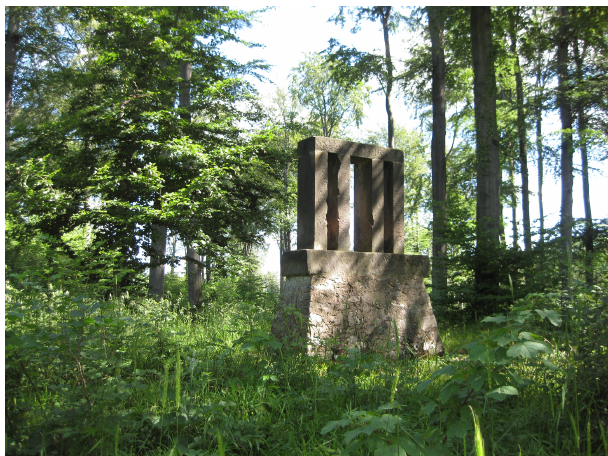
Figure 5. The “Südliches Meridianzeichen”, or the southern merid- ian mark, which is owned by the Gauss Society and is officially listed as a historic monument (photograph by the